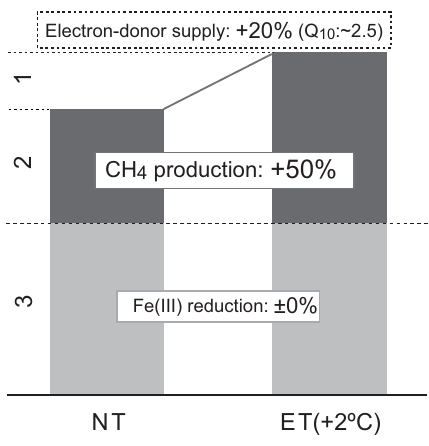
Fig. 6. A schematic illustration showing how (i) moderate enhancement of organic matter decomposition ( = electron-donor production) combined with (ii) temperature insensitivity of Fe reduction can cause a large increaseinCH 4 production(seetextfordetailedexplanation).